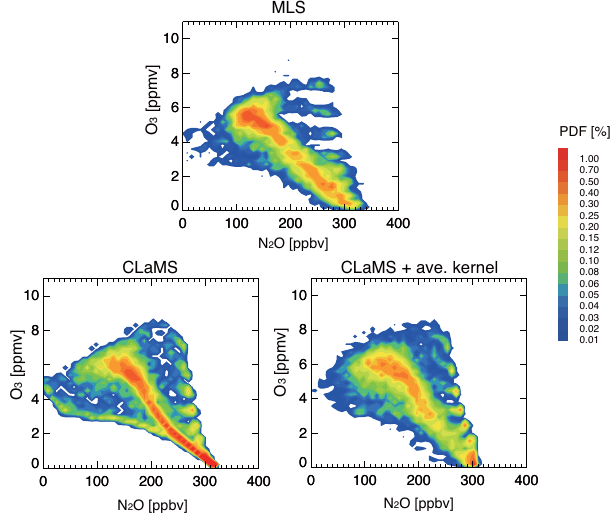
Figure A1. PDFs of N 2 O–O 3 correlations on 15 February 2009 from MLS observations (top); from the reference CLaMS simula- tion without applying the averaging kernel (bottom left) and after applying the averaging kernel (bottom